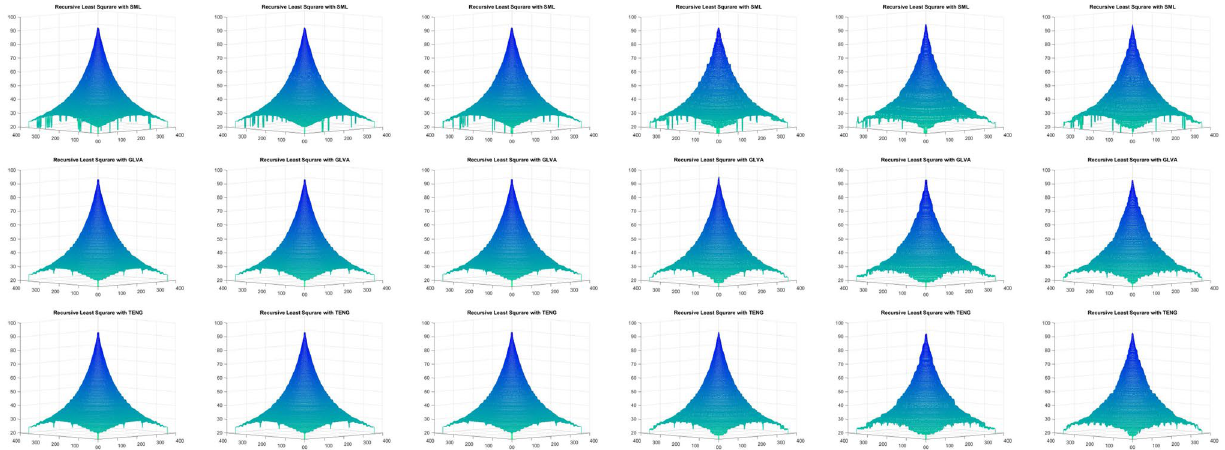
Figure 10. Shape reconstruction for simulated cone, using FM with proposed RLS method. (left to right) SML, GLVA, TENG. (top to bottom) σ 2 ξ